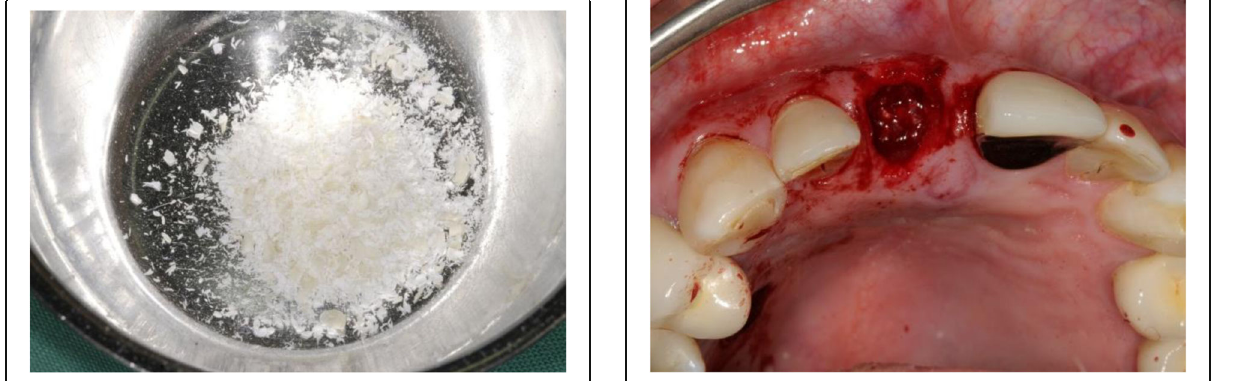
Fig. 6 Autologous dentin with the desired particle size